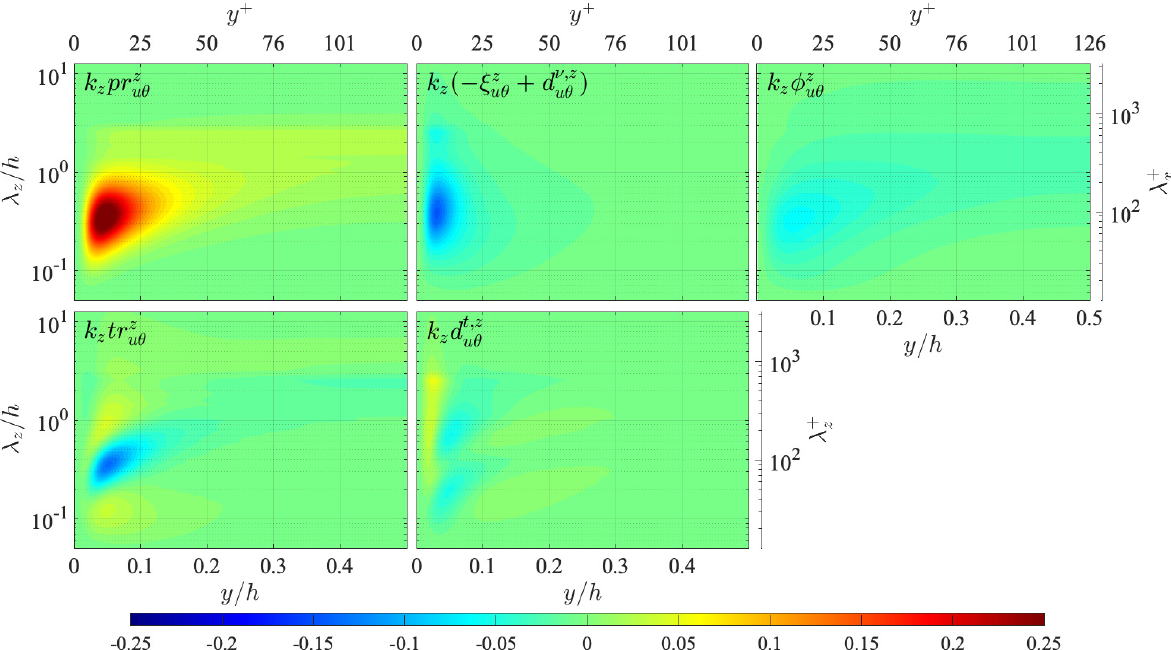
Figure 12. Distribution of terms in the transport equation of the velocity-temperature cospectrum E z presented in the same manner as in Figure 10: ( top left ) production pr z u θ + d ν , z terms ξ z ; ( top right ) pressure term φ z ; ( bottom right ) interscale transport tr z u θ u θ u θ tre ) turbulent diffusion d t , z . The terms are presented in the premultiplied form, and the values are u θ scaled by u 3 τ T τ / ν